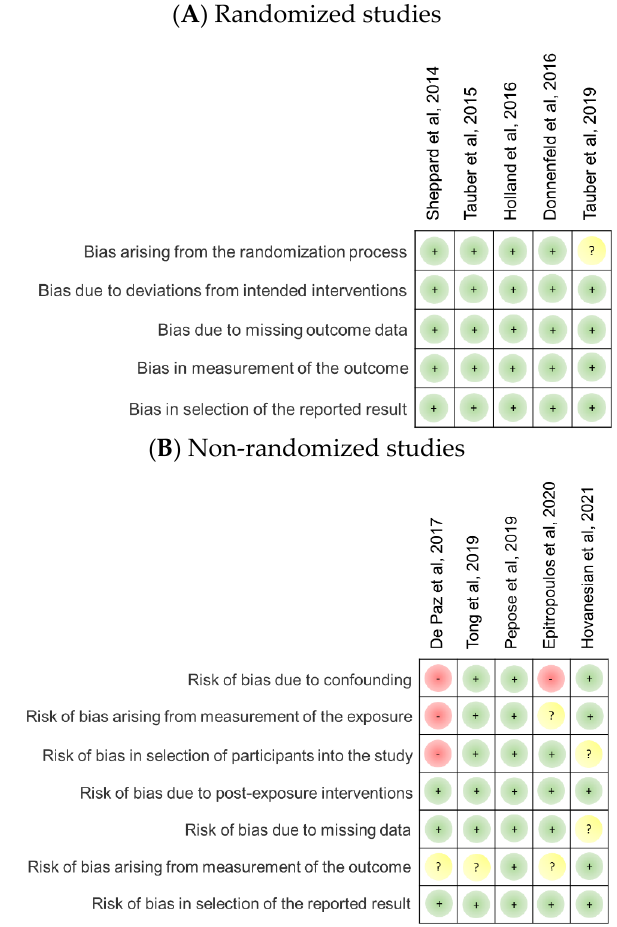
Figure 2. Risk of bias of included studies. ( A ) Risk of bias of included randomized controlled trials. ( B ) Risk of bias of included nonrandomized studies. A green dot denotes the low risk of bias, yellow for unclear risk of bias, and red for high risk of bias